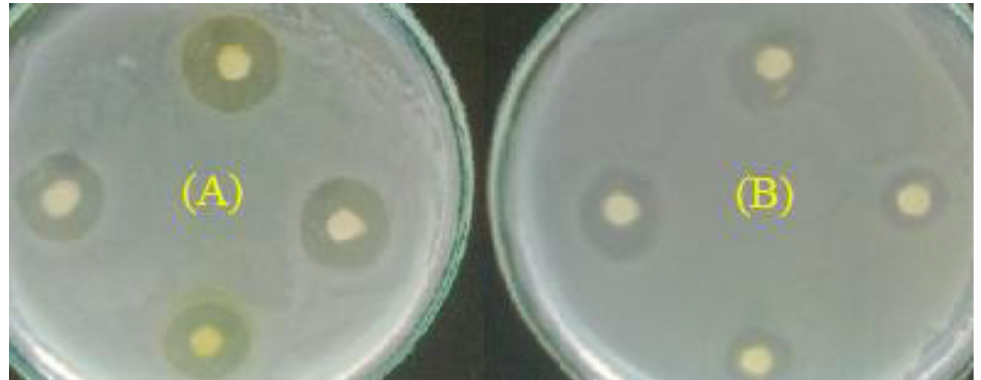
Fig. 6. Antibacterial activity of Au-NPs solution, against S. aureus (ATCC 51153) (a) and E. coli (ATCC 35218) (b). All the concentration of gold nanoparticles are 10µL (5.4 ppm).